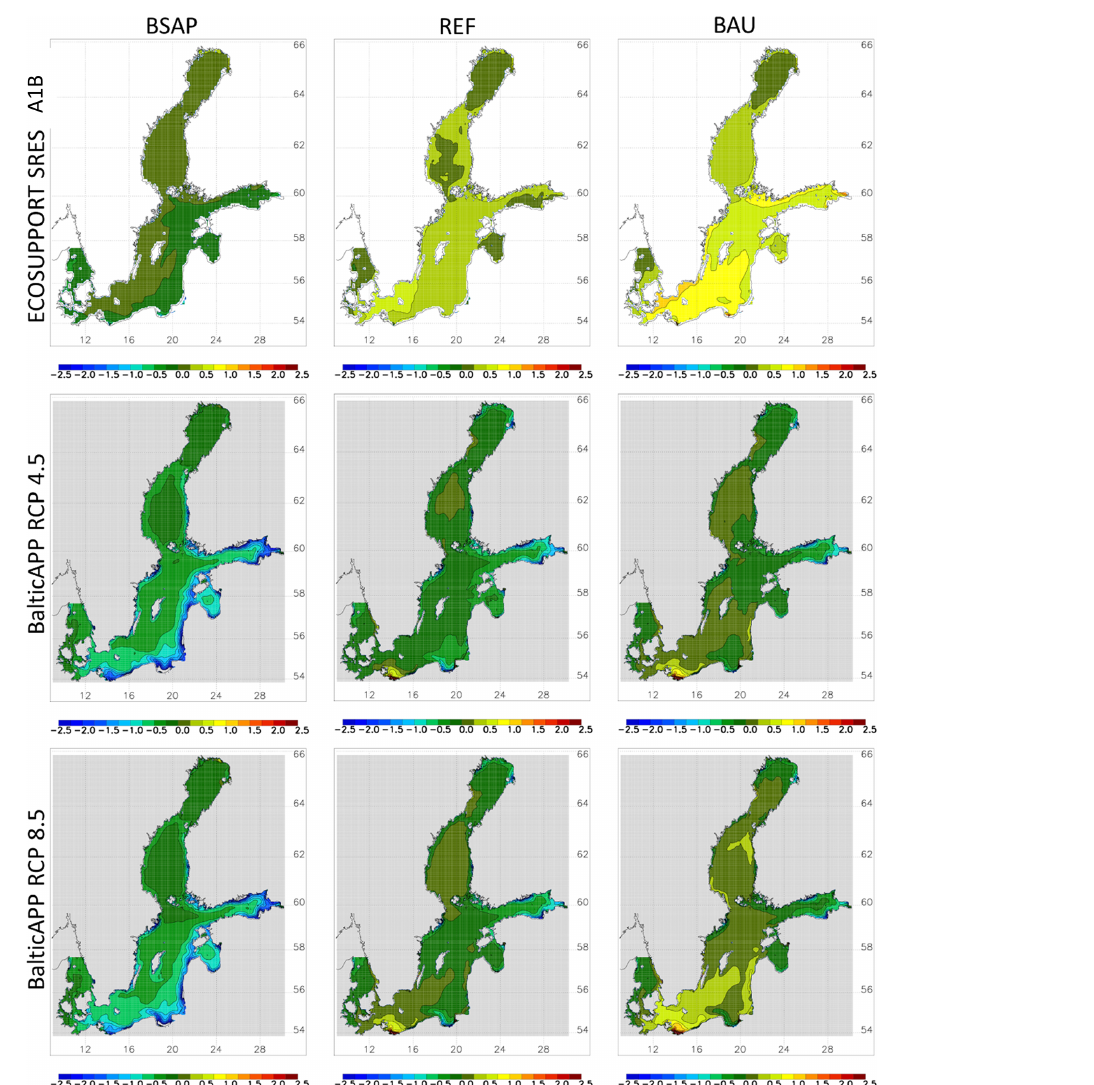
Figure 24. As in Fig. 21 but for annual mean surface phytoplankton concentration changes (mgChlm − 3 ). Concentrations are vertically averaged for the upper 10m. (Source: Meier et al., 2011b; Saraiva et al.,